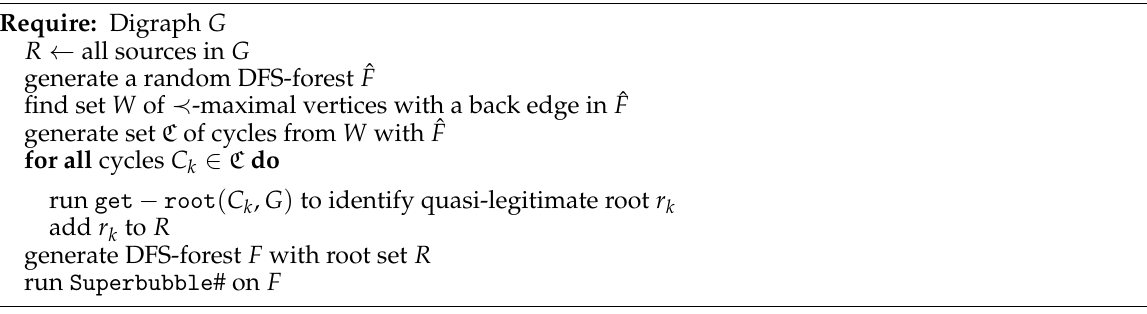
Algorithm 2 Identification of all superbubbles in an arbitrary digraph G